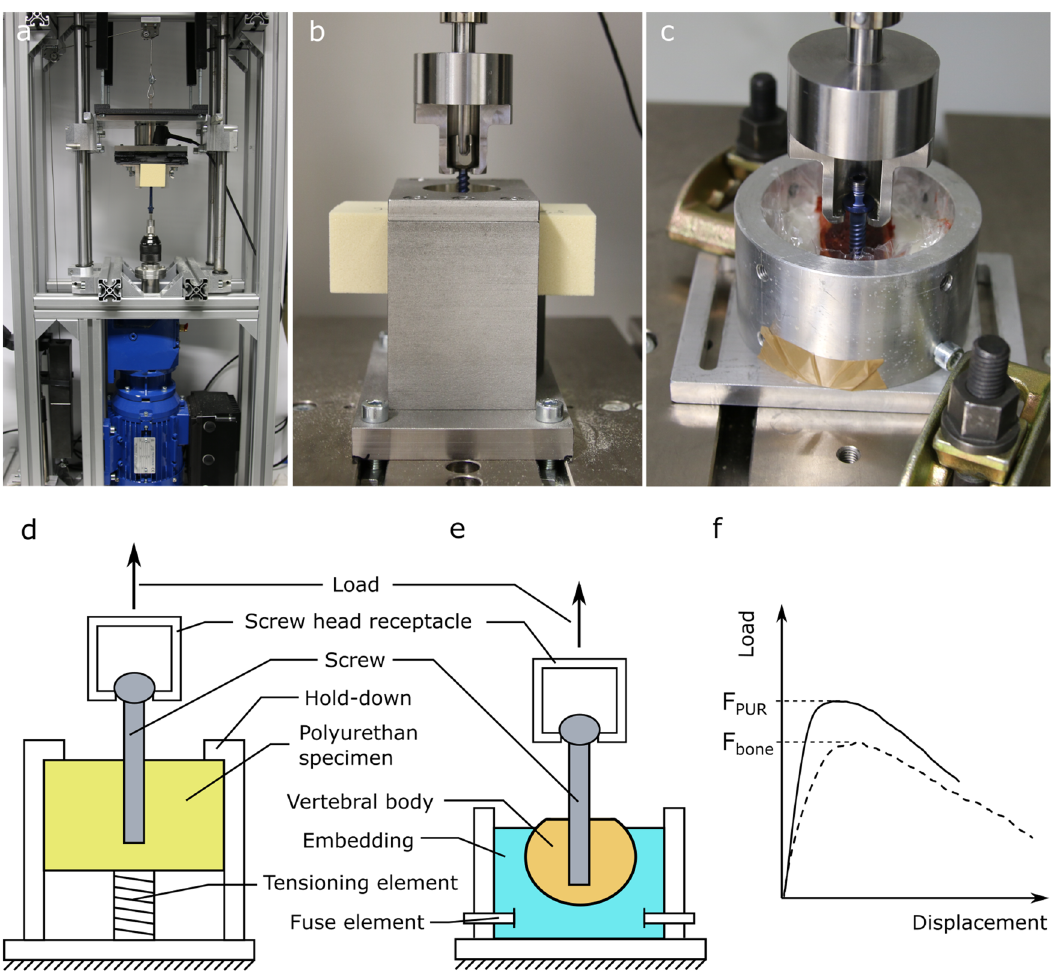
Figure 2. Experimental set-up: ( a ) screw-in test rig, ( b ) pull-out test from synthetic foam, ( c ) pull-out test from vertebral body of a body donor, ( d ) pull-out test from synthetic foam schematic, ( e ) pull-out test from vertebral body of body donor schematic and ( f ) qualitative progression of representative force–displacement curves from polyurethane foam and bone